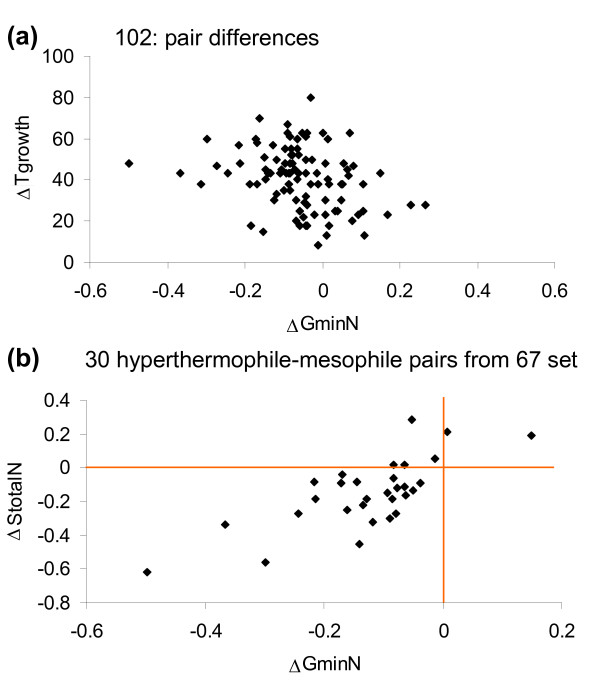
Differences within homologous pairs. (a) Correlation between the difference in growth temperature and the difference in GminN for the 102 thermophile-mesophile pairs in the 291 dataset that have an E-value < 10-2. (b) Correlation between the difference in GminN and the difference in StotalN for the 30 hyperthermophile-mesophile pairs in the 67 dataset. Lines of zero ΔStotalN and ΔGminN are marked.